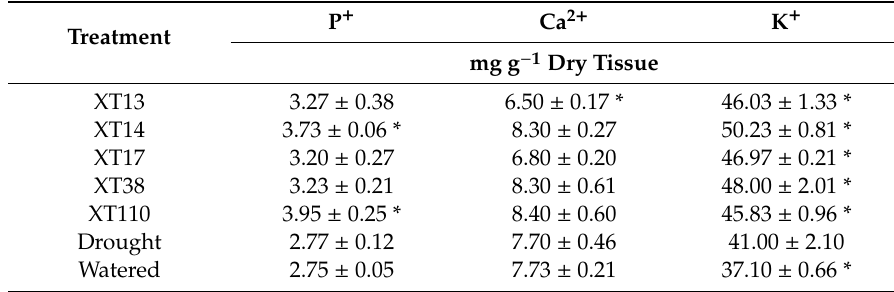
Table 4. Influence of drought stress and Bacillus spp. inoculation on leaf uptake of P + , K + , and Ca 2+ in maize plants.